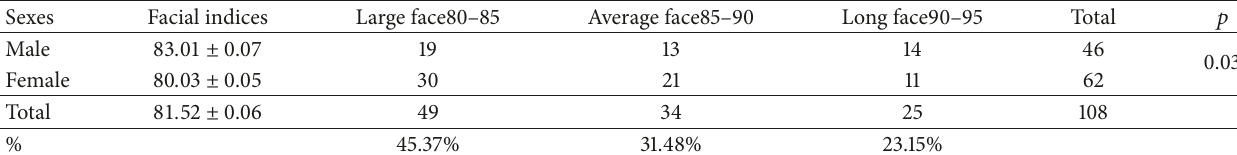
Table 4: Distribution of facial shapes based on gender.